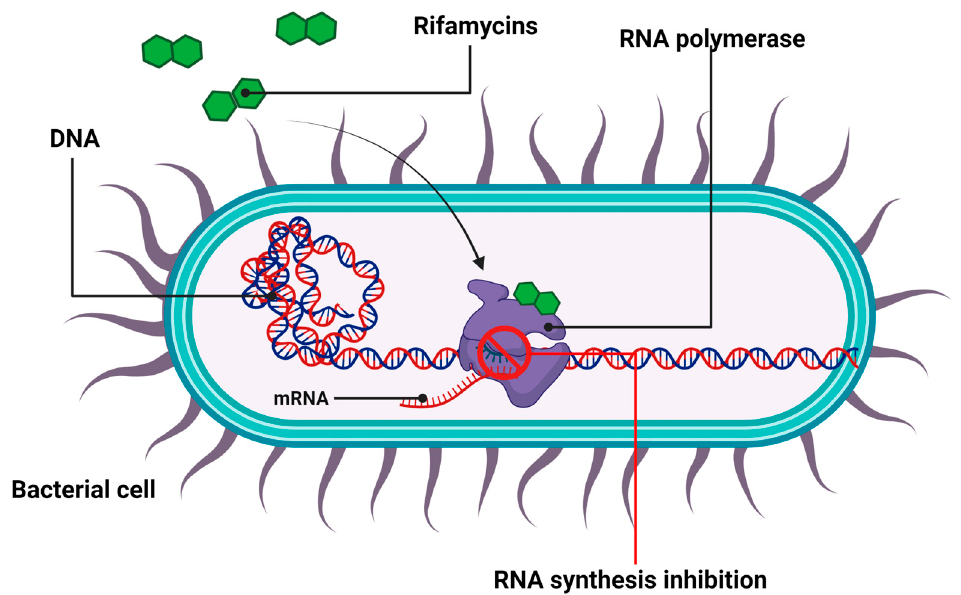
Figure 4. A model of rifamycin action. Figure created with Biorender.com.